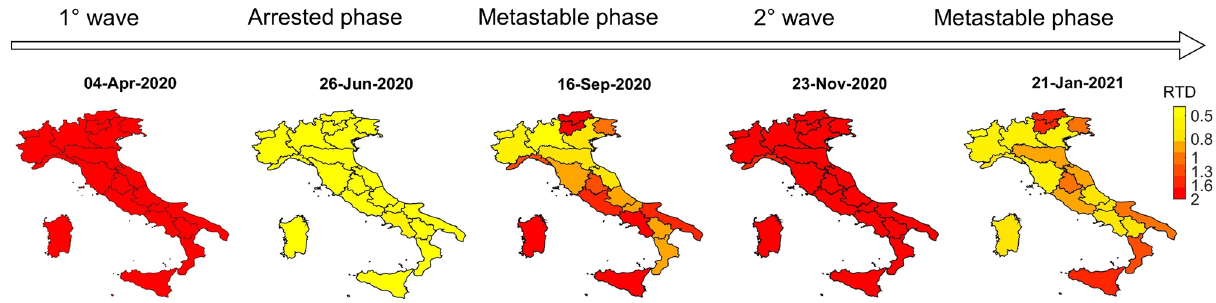
Figure 5. Geographic maps of Italian regions at different time in different phases with their local RTD values. The color bar evolution from yellow to red is due to T d and R t values and to the spreading of